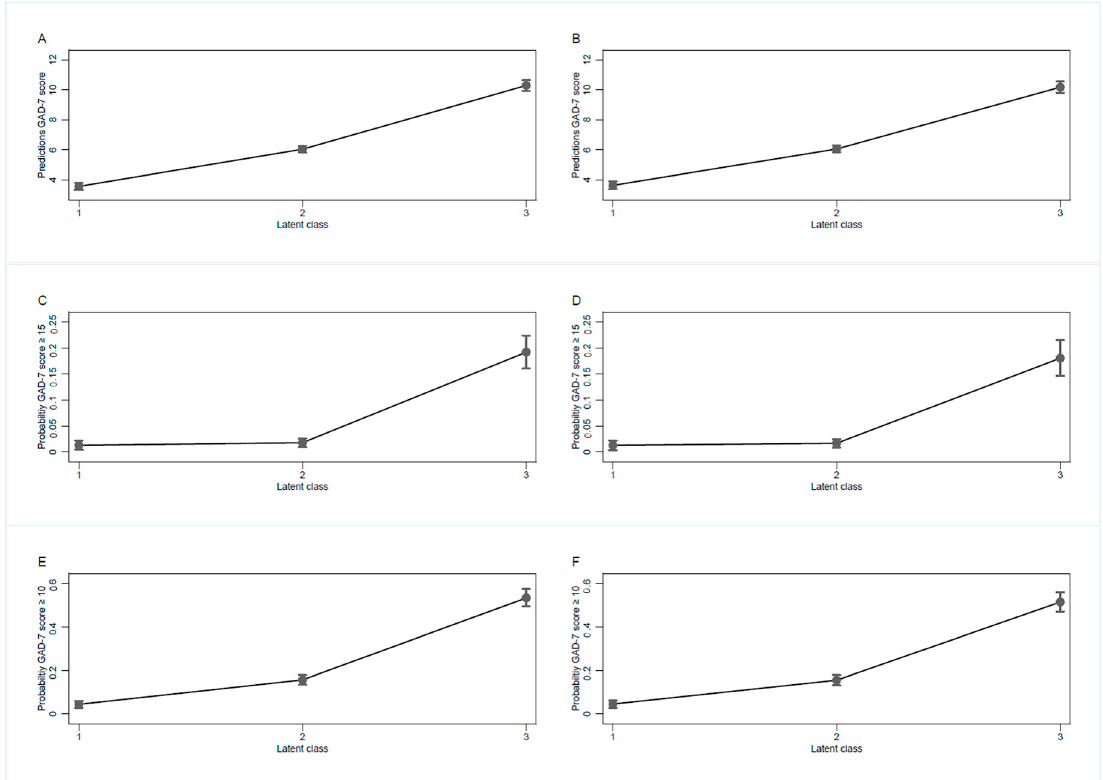
Figure 2. GAD-7 Predicted Marginals. Legend: N = 2 ′ 223; Latent class 1 = low; 2 = moderate, 3 = strong impact on wellbeing and daily life, based on latent class analysis; GAD 7: General anxiety disorder scale; unadjusted estimates (prediction and probability): A, C, E, estimates adjusted for age, sex, social status and affiliation: B, D, F. A and B estimated from OLS regression models with robust standard errors. C, D, E, and F estimated from logistic regressions with robust standard errors.